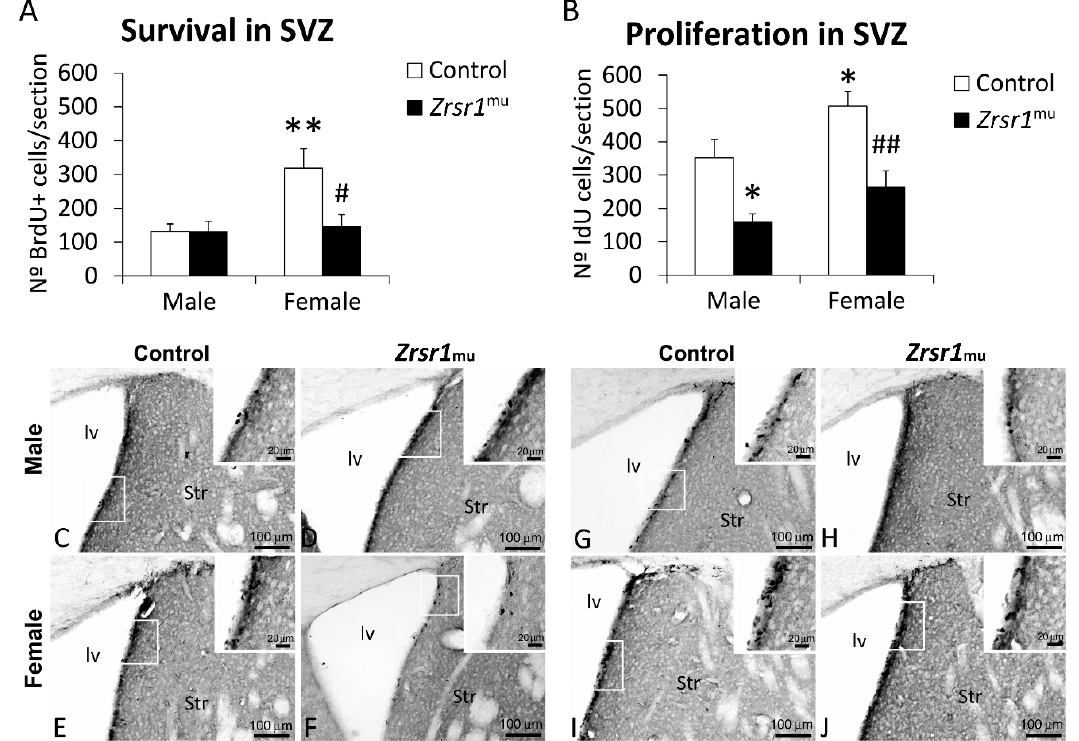
Figure 5. Newborn cell survival ( A ) and neural stem cell proliferation ( B ) respectively assessed by the number of BrdU- and IdU-immunoreactive ( + ) cells in the subventricular zone (SVZ) of male and female wild-type and Zrsr1mu mice. Low- and high-resolution photomicrographs of representative images showing BrdU + cells ( C–F ) and IdU + cells (G–J). Arrowheads indicate labeled nuclei. Bars represent the mean ± SEM ( n = 7–8 / group). Tukey ( A ) or simple e ff ect analysis ( B ): * p < 0.05, ** p < 0.01 female vs. control male and # p < 0.05 ## p < 0.01 wild-type vs. Zrsr1 mu . Str, striatum; lv, lateral ventricle.